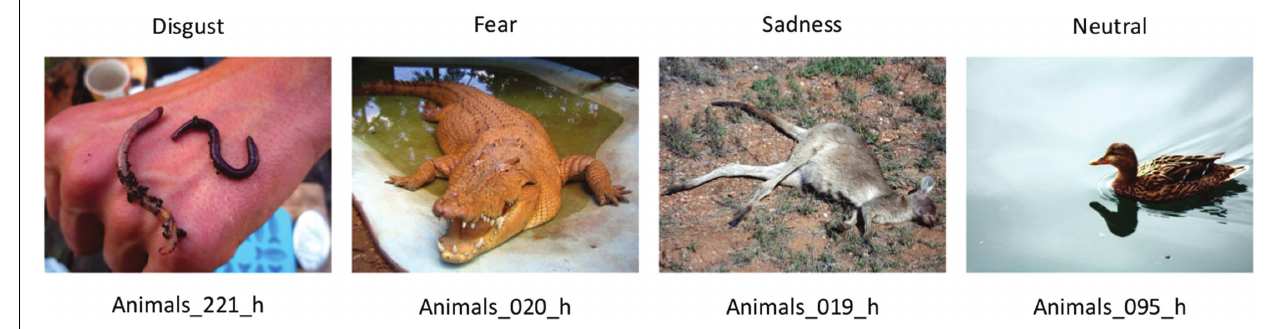
FIGURE 1 | Exemplary stimuli used in the current study eliciting disgust, fear, and sadness together with a neutral item. Note that the exemplary stimuli are only from Animals category and are not extreme for each emotion. Numbers represent order of the stimuli in the NAPS